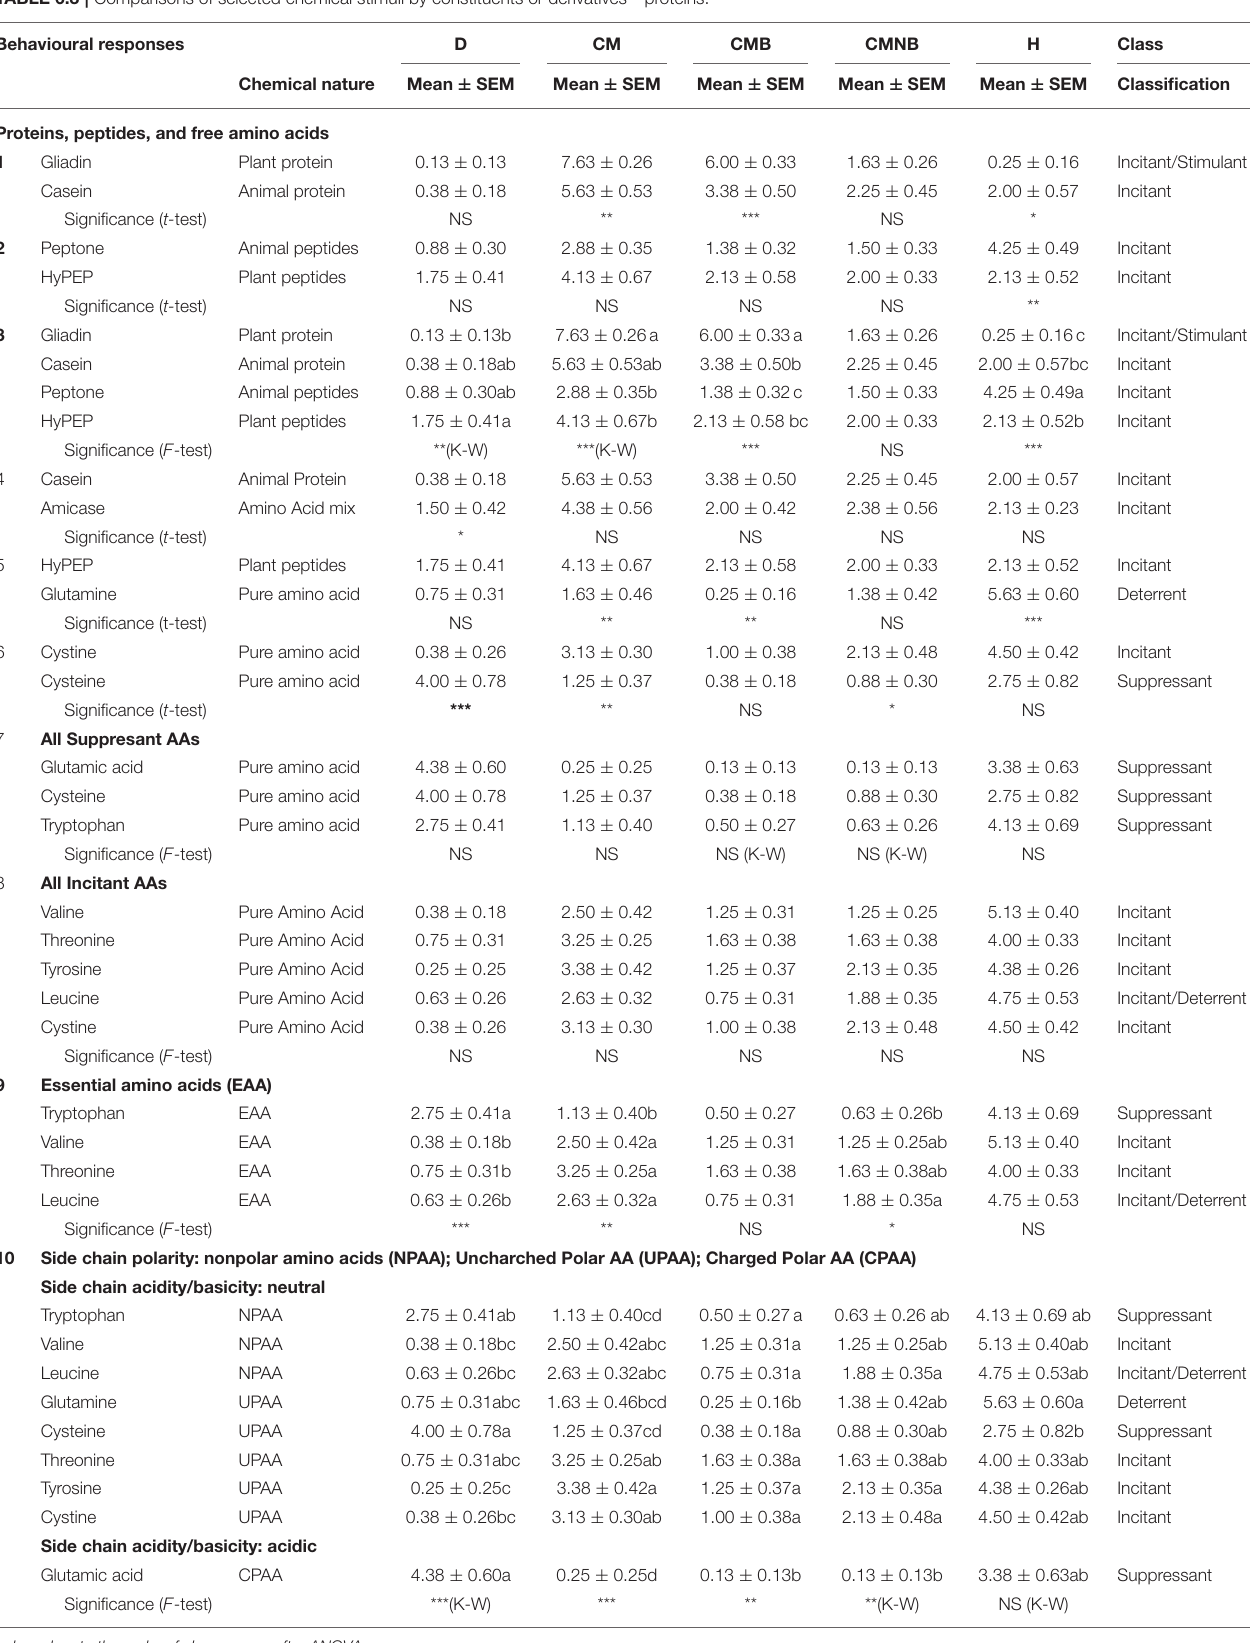
TABLE 6.3 | Comparisons of selected chemical stimuli by constituents or derivatives—proteins. Behavioural